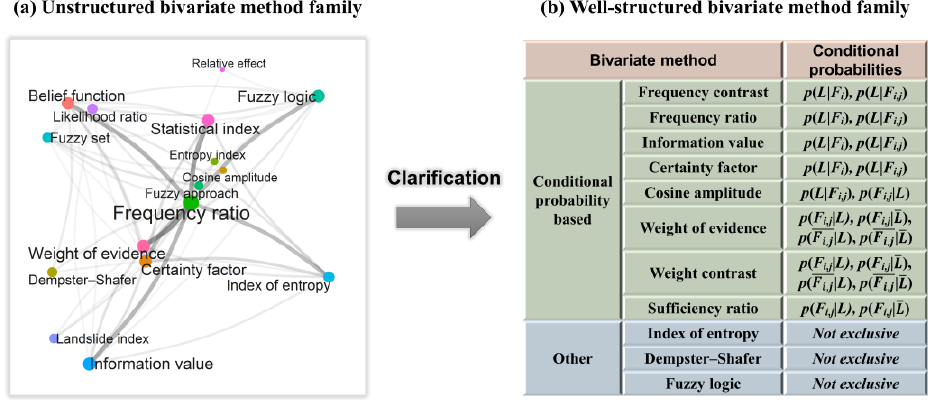
Figure 1. Clarification of bivariate methods of landslide susceptibility analysis. ( a ) Unstructured bivariate method family (before clarification) is illustrated with a relationship network. Larger dots indicate methods with higher frequencies of occurrence in titles and abstracts of publications with a topic of landslide susceptibility, and thicker lines indicate higher frequencies of co-occurrence. Data of publications were accessed from the Web of Science Core Collection on 19 July 2022. ( b ) The well-structured bivariate method family (after clarification) is illustrated with a table. The eight conditional-probability-based methods exclusively, and other methods inclusively, depend on empiri- cal conditional probabilities of landslide occurrence. Details of conditional probabilities are referred to in the main text (Section 2.2). The 8 conditional-probability-based methods, which are the main focus of this contribution, are summarized in Table 1 and detailed in Section 2.2.3. The 3 other biva- riate methods are briefly introduced in Section 2.2.4.